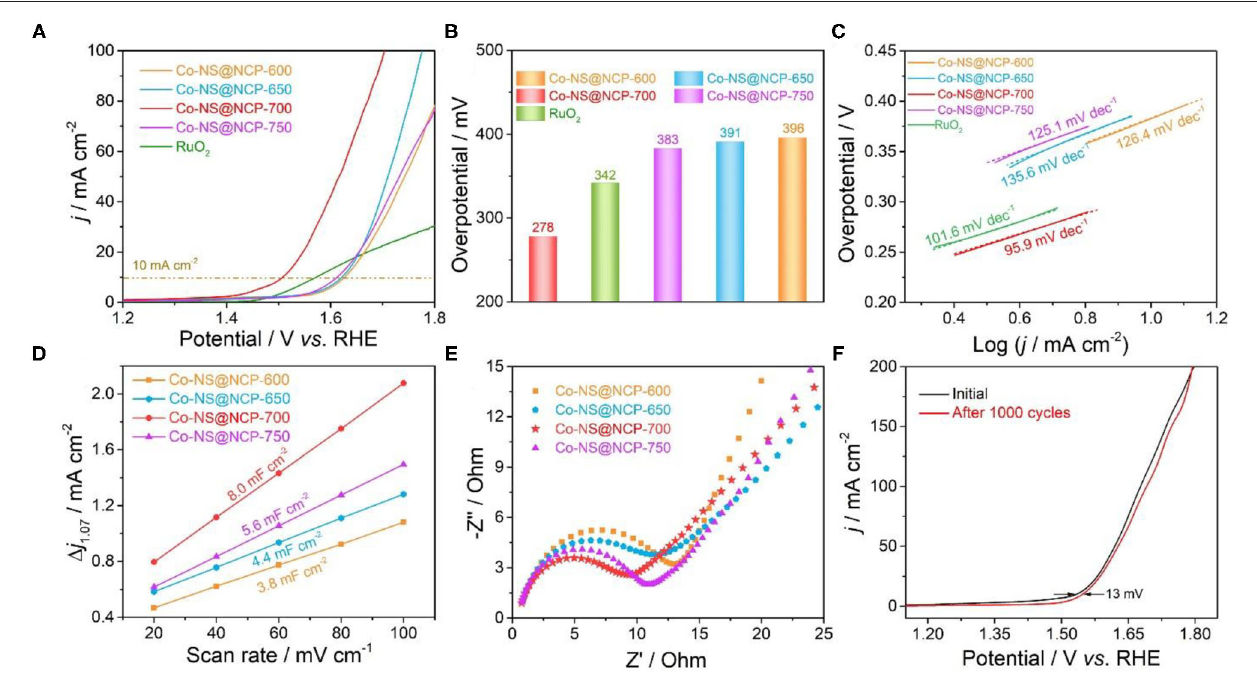
FIGURE 4 | Electrocatalytic OER performance of different samples in 1.0M KOH electrolyte: (A) LSV polarization curves; (B) overpotentials at a current density of 10mA cm − 2 ; (C) Tafel plots derived from the panel; (D) C dl values; (E) EIS Nyquist plots; (F) LSV polarization curves of the Co-NS@NCP-700 catalyst before and after 1,000